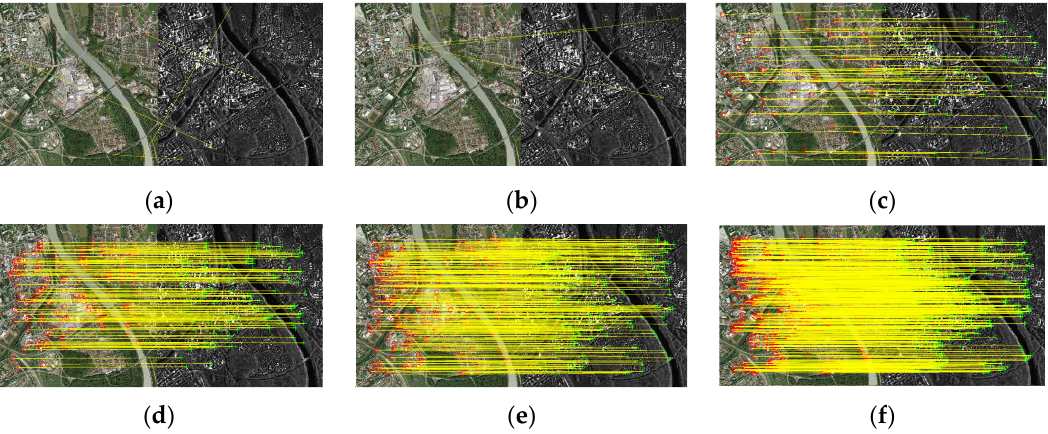
Figure 15. Experimental results of pair 3. The registration results from ( a ) to ( f ) are SIFT, SAR-SIFT, OS-SIFT, HOPC, RIFT, and MSPCO, respectively.